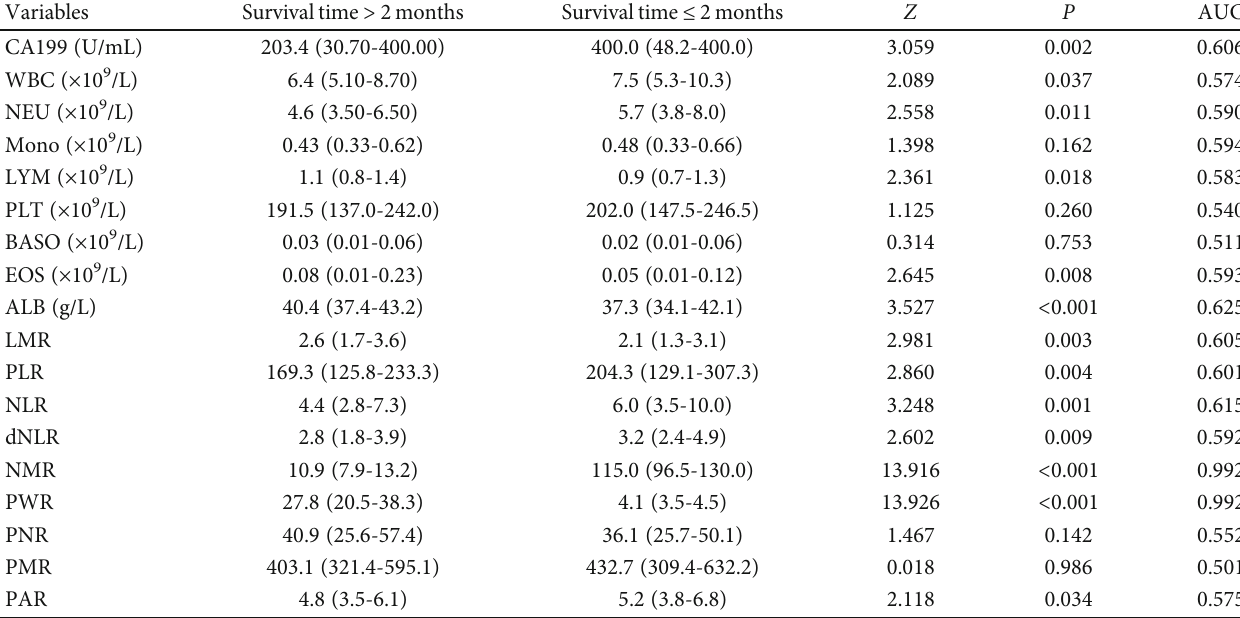
Table 2: Comparison of di ff erent blood cell count and in fl ammatory markers in patients with di ff erent survival time groups.